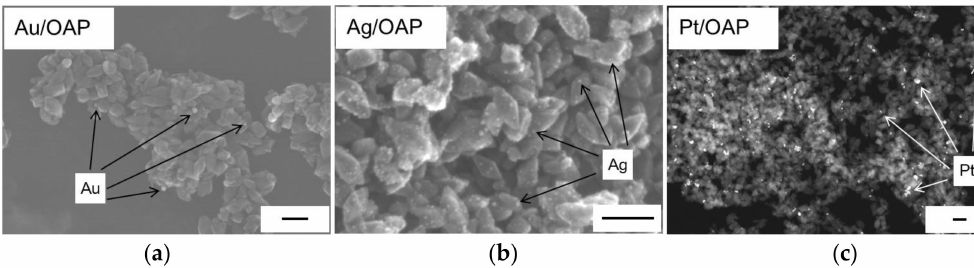
Figure 8. STEM images of: ( a ) Au / OAP (SE mode); ( b ) Ag / OAP (SE mode) and ( c ) Pt / OAP (ZC mode). Scale bars correspond to 50 nm.